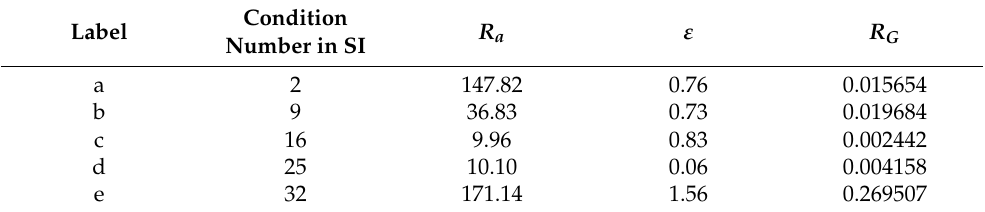
Figure 4. Sediment mass change curve and morphology structure change diagram during LIDS: ( a ) Change curve of dimensionless deposition mass with time; ( b ) Sediment morphology and local enlarged view corresponding to point A of the curve ( a ); ( c ) C (aq) concentration distribution corresponding to point A; ( d ) Sediment morphology and local enlarged view corresponding to point B of the curve ( a ); ( e ) C(aq) concentration distribution corresponding to point B; ( f ) The sediment morphology changes with time. From left to right, each cloud image has an interval of 100,000 time steps. Table 3. Sediment morphologies under different conditions when the time step is 500,000